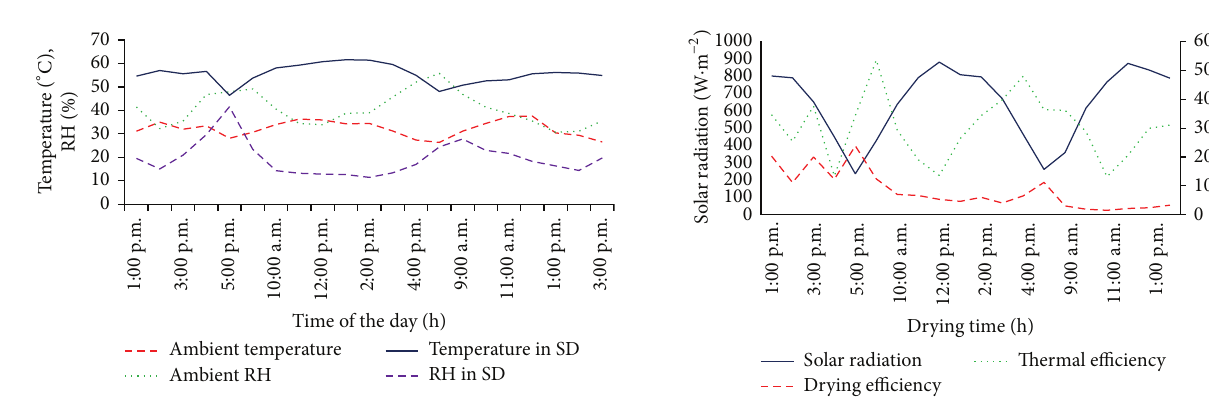
Figure 3: Thermal efficiency and drying efficiency as compared to solar radiation for typical experiment.